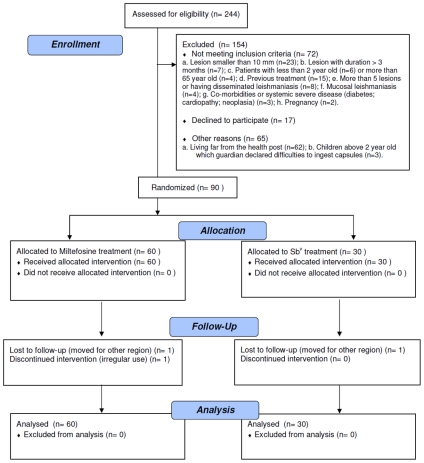
Trial flowchart.